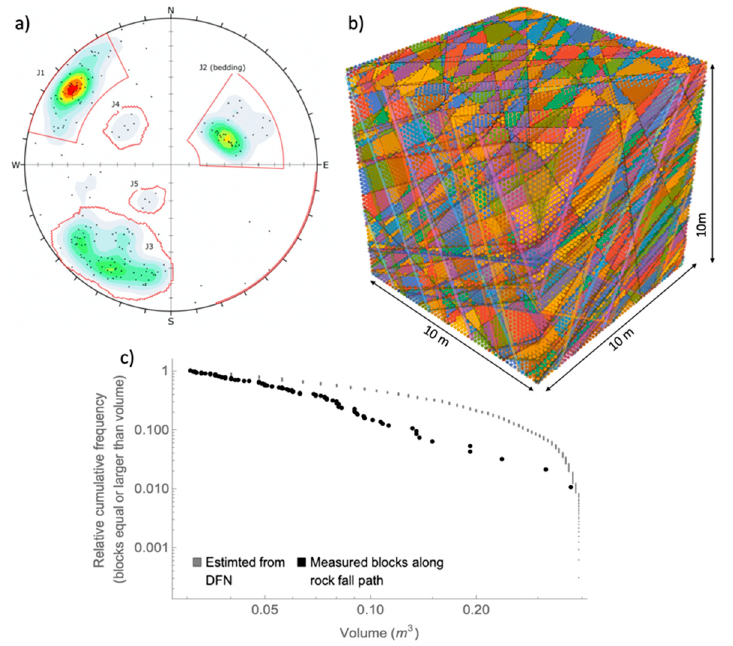
Figure 14. Discontinuity sets as a result of the virtual structural mapping ( a ) for the S042 Site. One iteration of the DFN for the S042 Site ( b ). Fragmented rock fall volume cumulative distribution based on the DFN realizations compared to block volumes surveyed at the toe of the talus slope, DFN volumes are truncated to the minimum range of surveyed block volumes for accurate comparison (lack of survey of small fraction of blocks) ( c ). Adapted from [56].